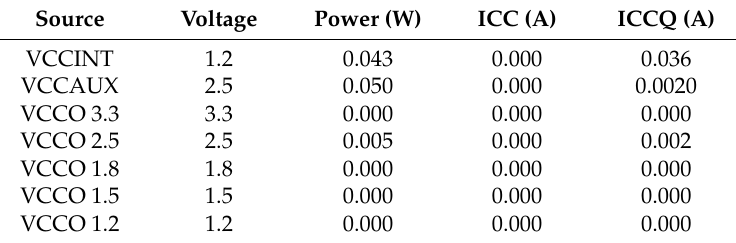
Table 4. Voltage summary of the proposal